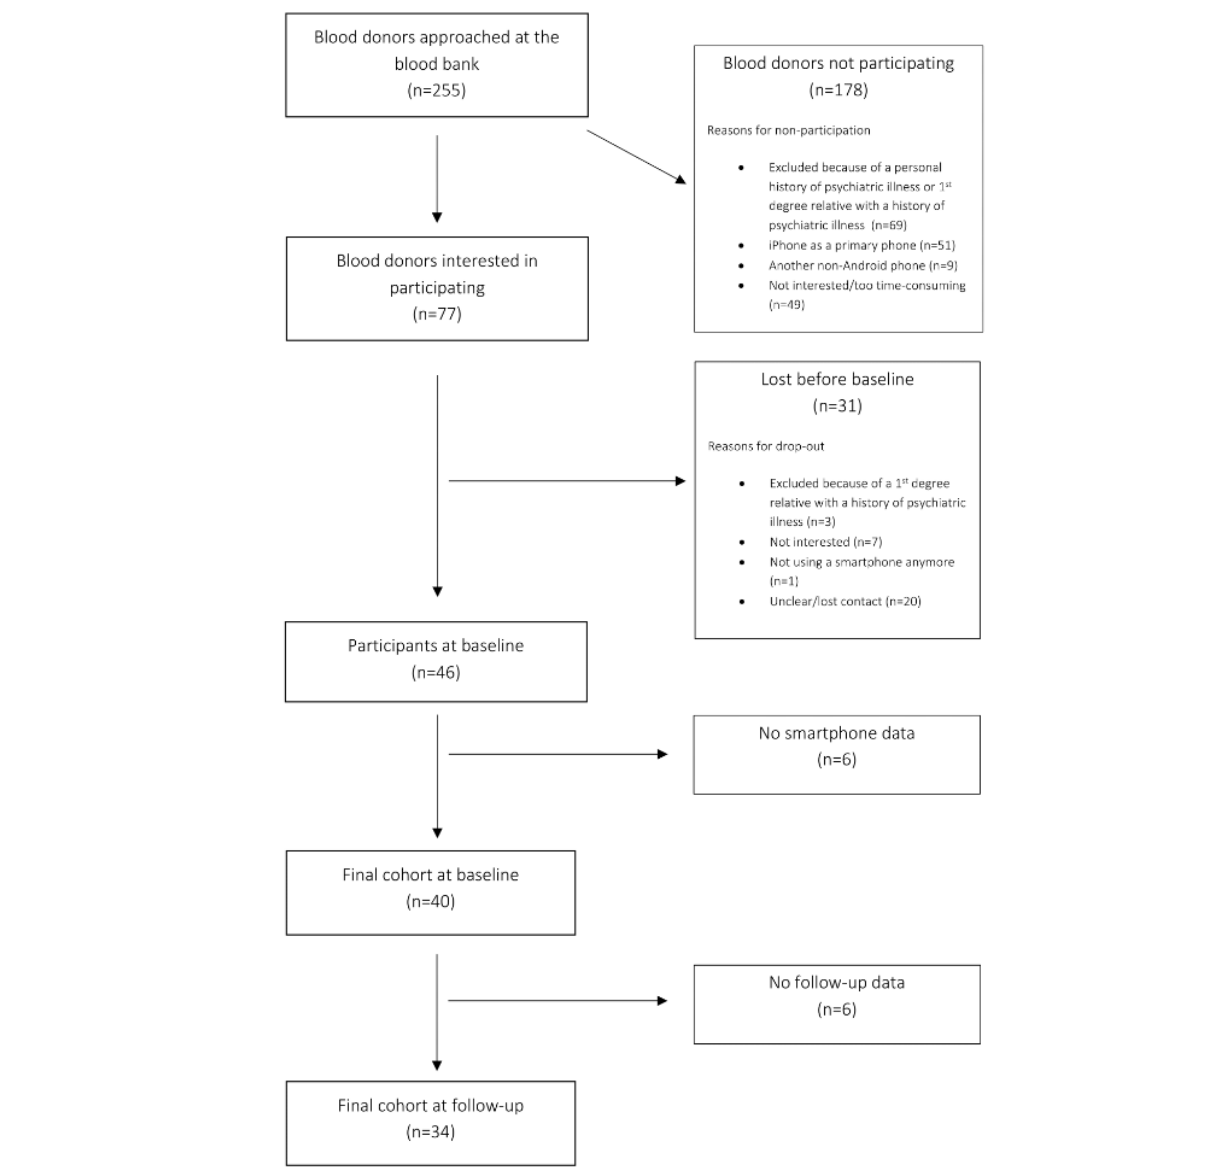
Figure 2. Flow diagram of participants recruited from Rigshospitalets blood bank from November 2015 to August